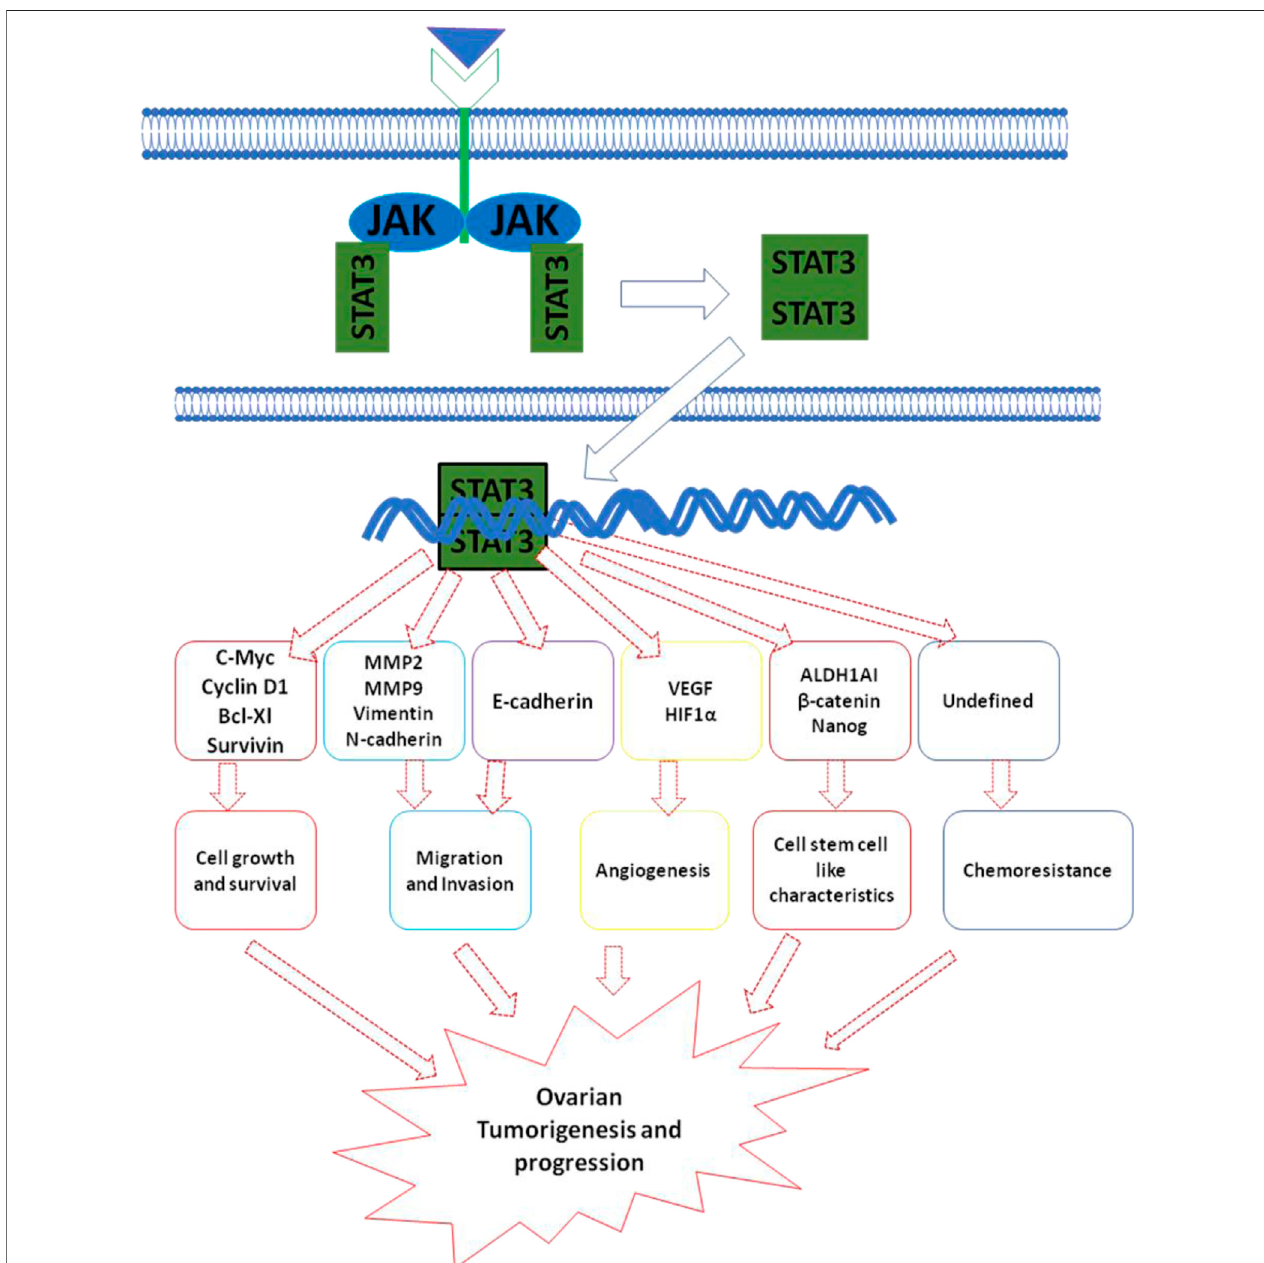
FIGURE 3 | JAK/STAT signaling pathways its downstream mediators and mechanism associated with ovarian cancer.